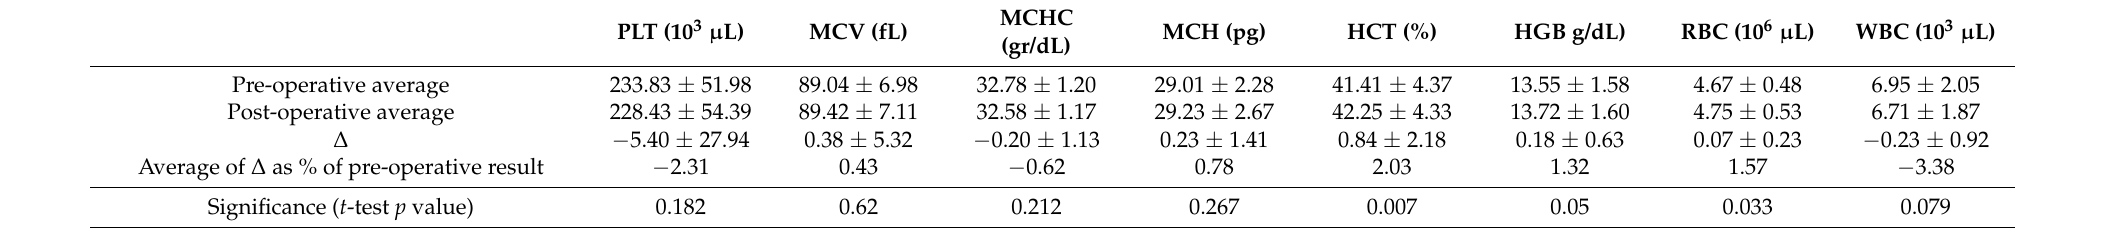
Table 1. Change between pre-operative and post-operative CBC parameters ( n = 49).